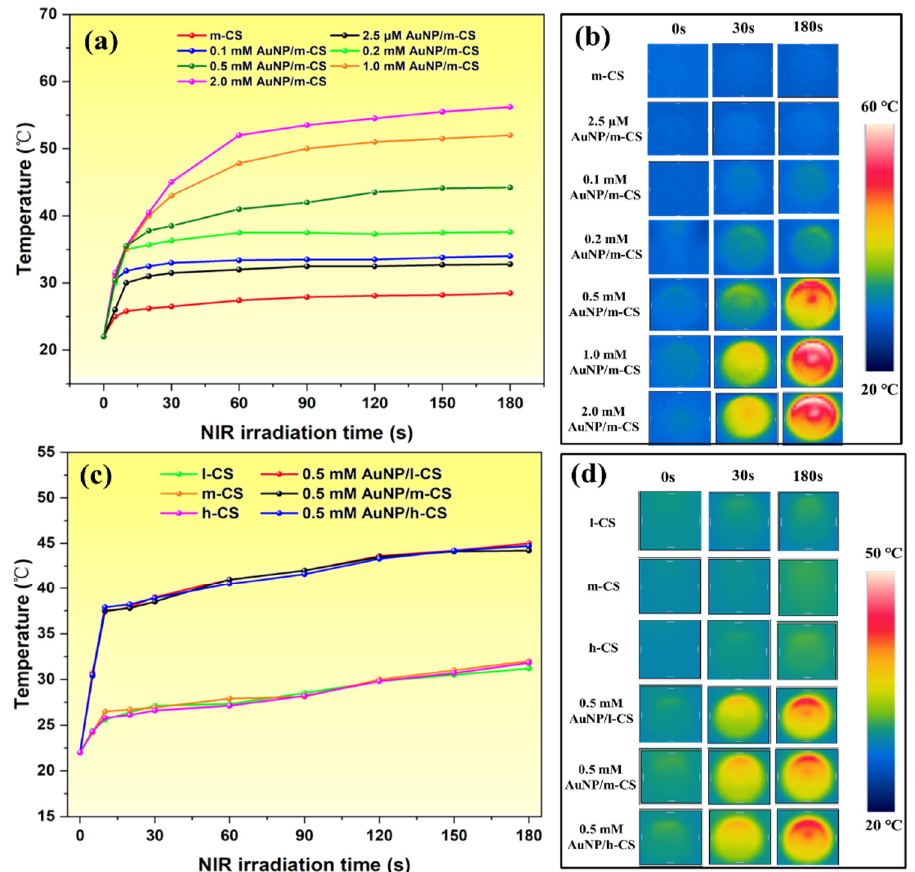
Figure 7. Temperature profile of AuNP/CS nanocomposites under NIR laser irradiation (power density = 0.8 W cm − 2 ). ( a ) Effect of different HAuCl 4 concentrations on the photothermal conversion efficiency of AuNP/CS nanocomposites and ( b ) their correlating IR thermal images at different time intervals; ( c ) Effect of initial CS viscosity on the photothermal conversion efficiency of AuNP/CS nanocomposites and ( d ) their correlating IR thermal images at different time intervals.